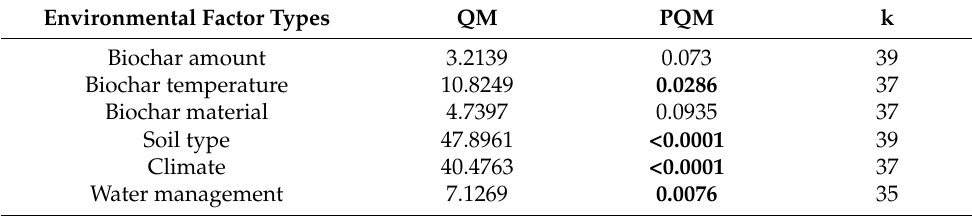
Table 1. Environmental factors affecting rice yield heterogeneity under biochar application scenarios.